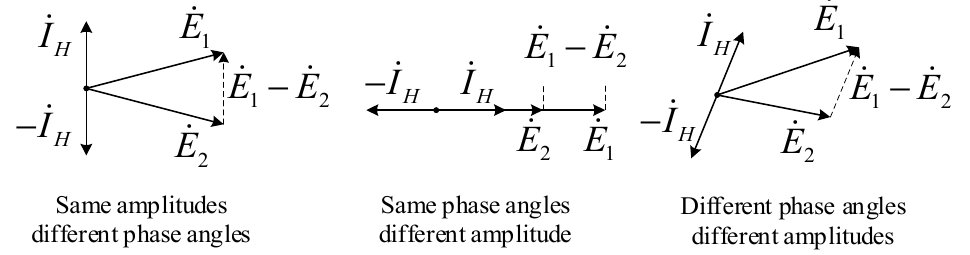
Figure 6. Output voltage and circulating current of parallel systems when output impedance is resistance.